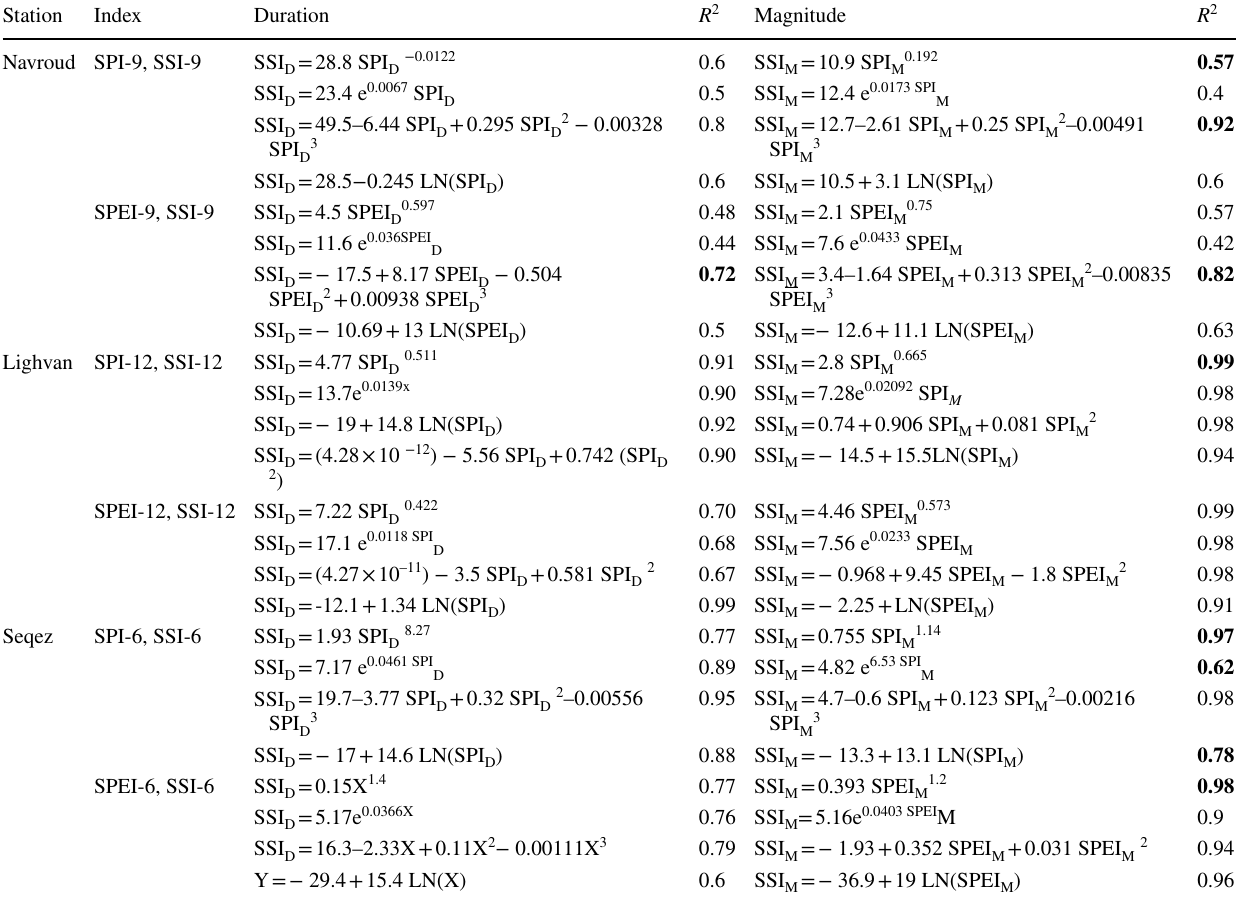
Table 5 Relationships of hydrological drought and meteorological drought